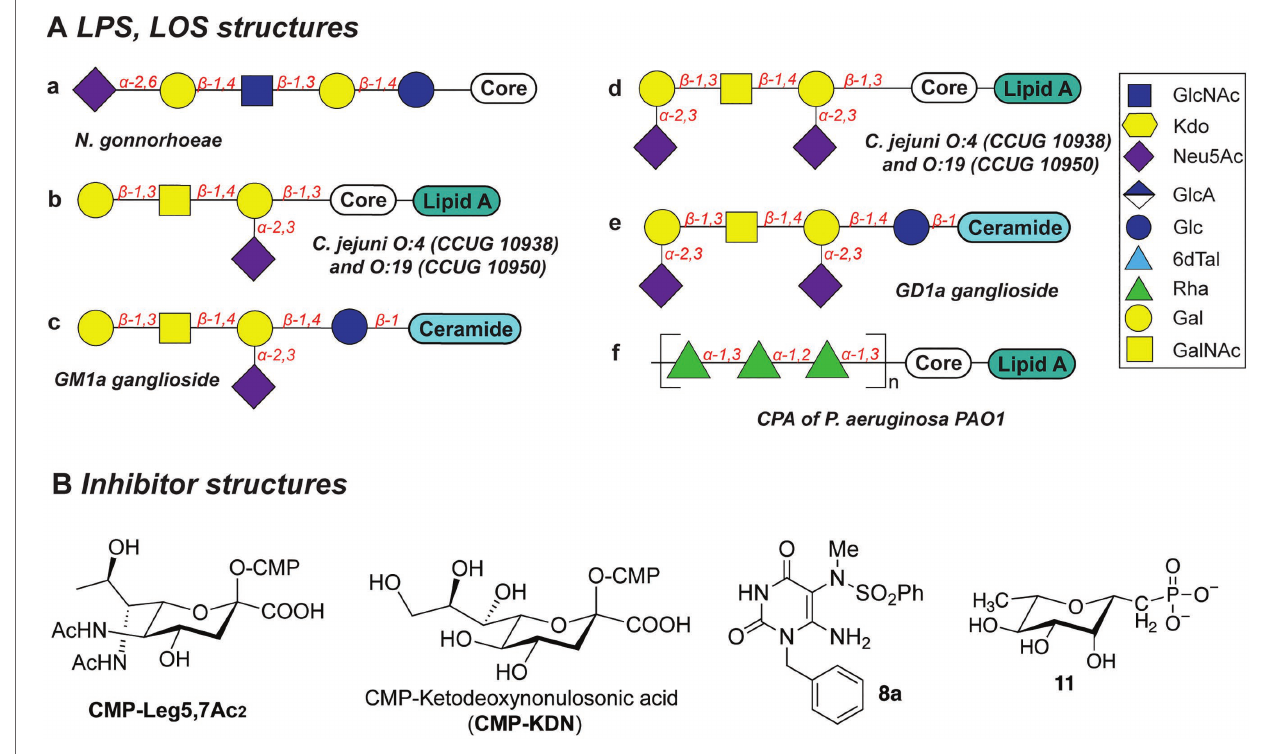
FIGURE 5 | (A) Structures of LOS described in this section. (B) Structures of inhibitors discussed in this